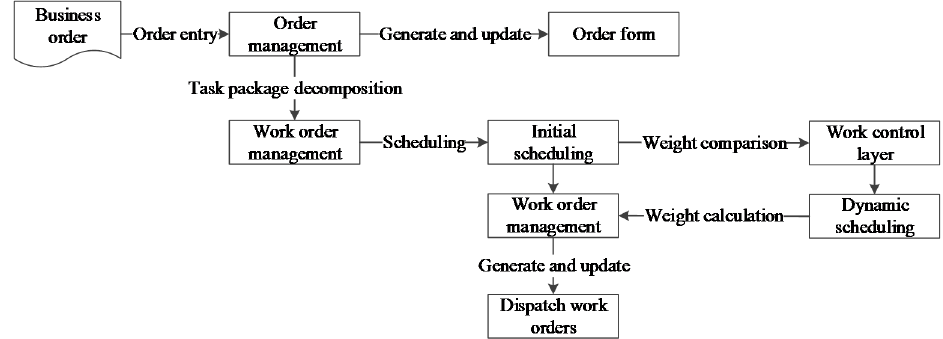
Figure 7. Business flow chart of production planning and scheduling module.